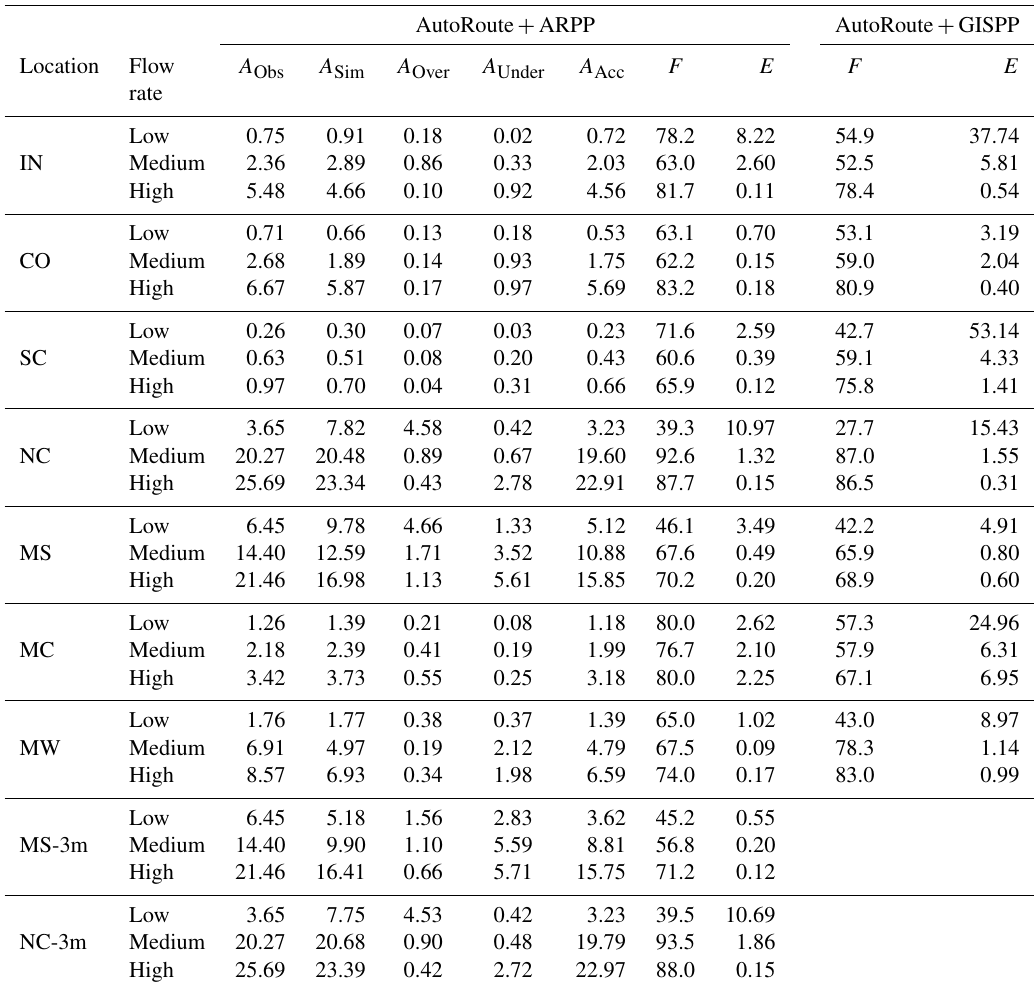
Table 3. F statistic ( F , percentage) and error bias ( E ) for AutoRoute + ARPP and AutoRoute + GISPP for each flow scenario at all seven test location. Inundation coverage areas ( A Obs , A Sim , A Over , A Under , and A Acc ) are also shown for AutoRoute + ARPP. F ranges between 0% and 100%, with a value of 100% indicating a perfect fit between the simulated and USGS flood inundation maps. E values less than 1 indicate a bias towards underestimation, E values greater than 1 indicate a bias towards overestimation, and an E value of 1 indicates no bias. All inundation coverage areas have units of square kilometers (km 2 ). F , E , and inundation coverage areas are also shown for the two sites tested using higher-resolution elevation data (MS-3m and